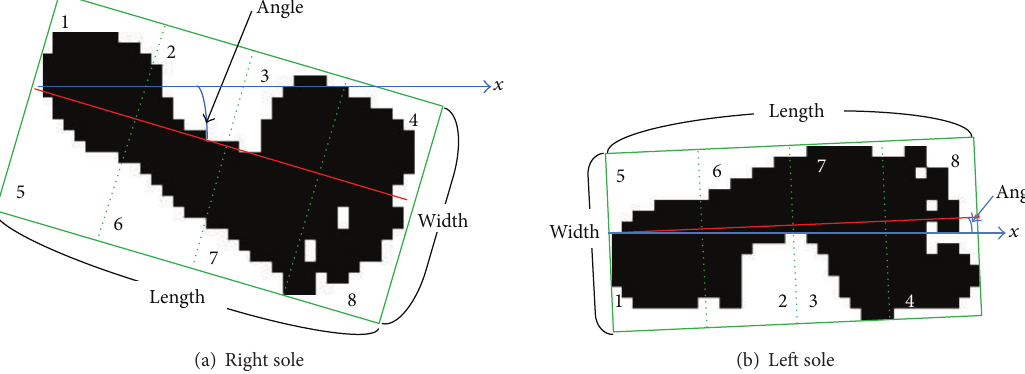
Figure 7: Example of footprint and these features.